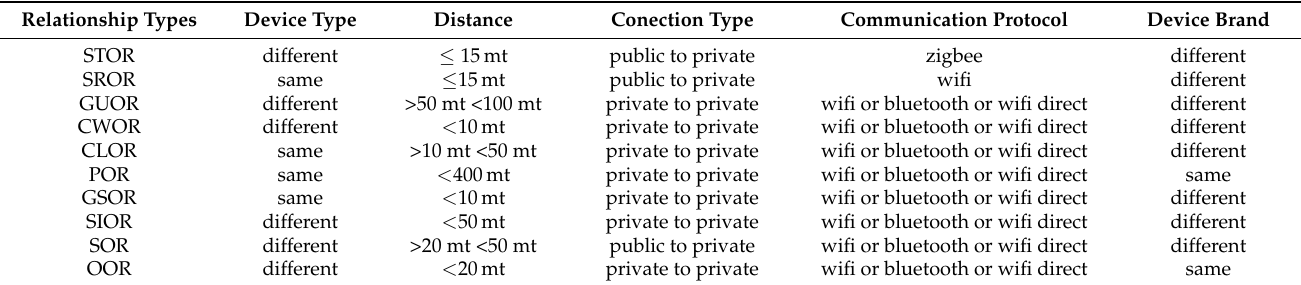
Table 4. Semantic rules for establishing relationship.